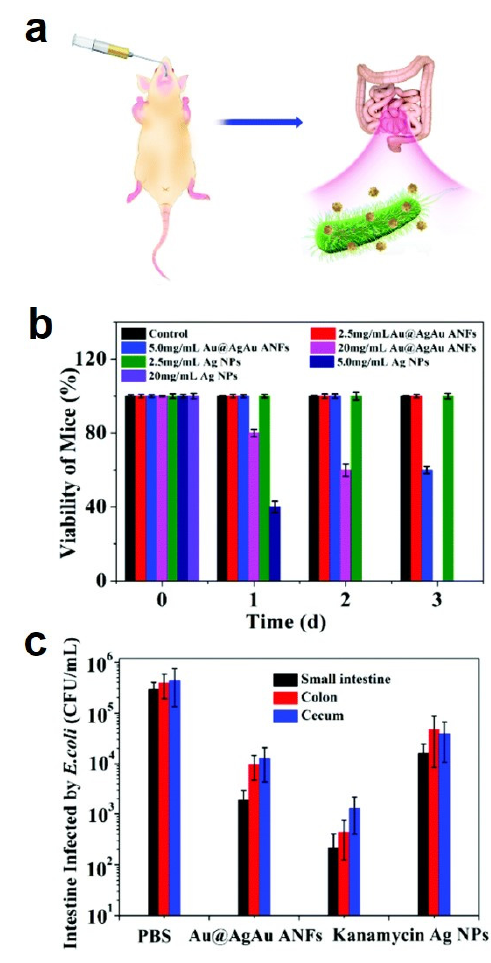
Figure 8. ( a ) Schematic of the evaluation of the in vivo antibacterial activity of Au@AgAu alloy nanoflowers (ANFs). ( b ) Viability of the mice treated with different concentrations of Ag NPs